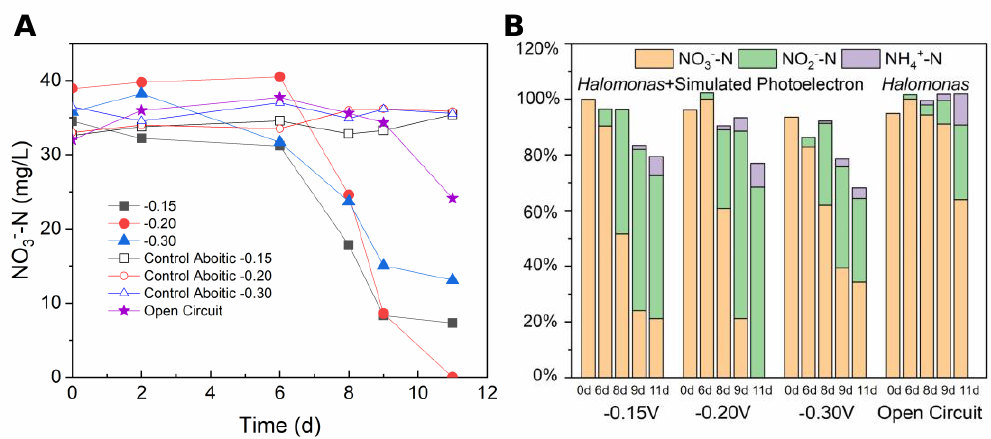
Figure 4. Time-course change of nitrate concentrations ( A ) and percentage of different N-compounds (nitrate, nitrite, ammonia) ( B ) in different experimental settings.